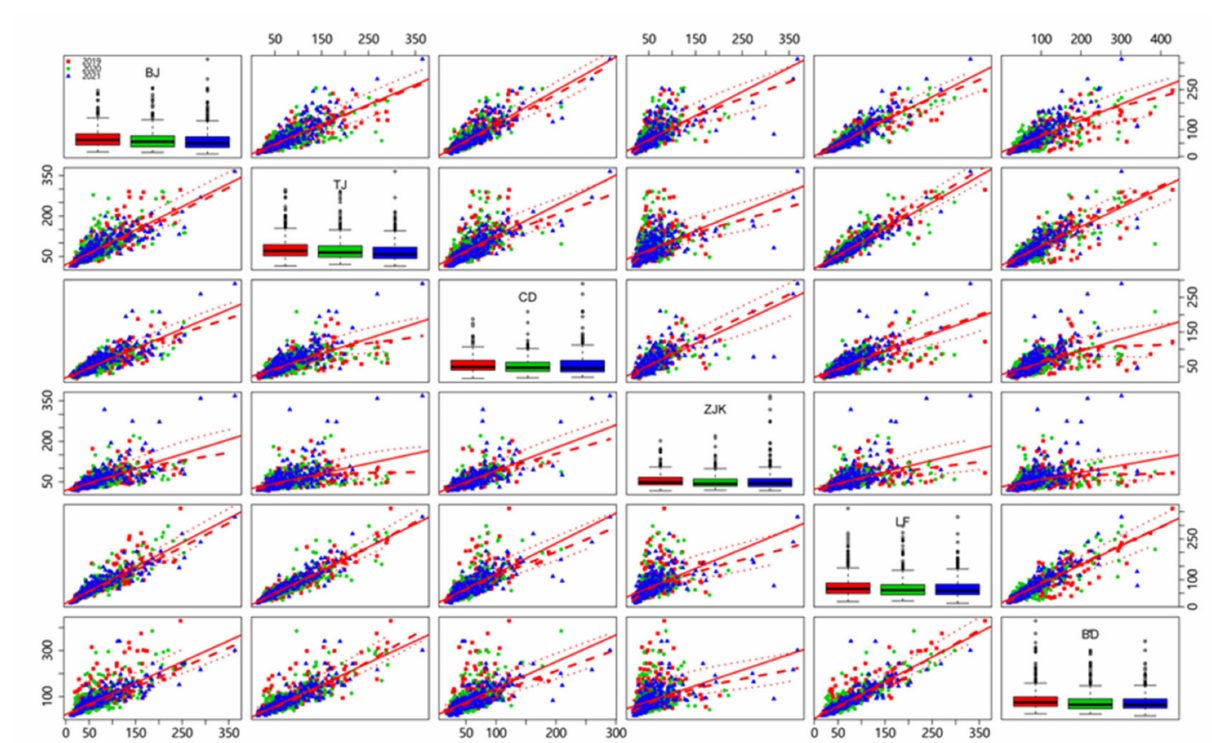
Figure A1. Relationship between AQI of Beijing and that of cities around Beijing. Note: red lines: linear regression fitted lines; dash lines: 95% confidence intervals for linear regression; thick dash lines: smooth fitted lines.